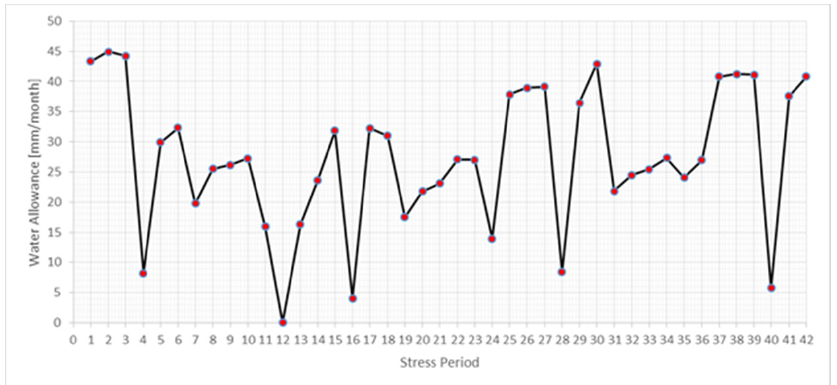
Figure 5. Water allowance as per actual discharge data in the Rohri canal.